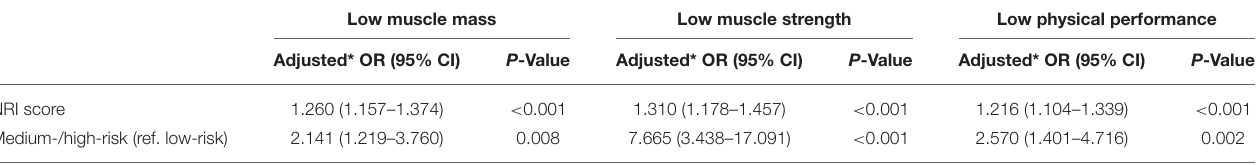
TABLE 4 | Association of nutritional status with low muscle mass, low muscle strength, and low physical performance.